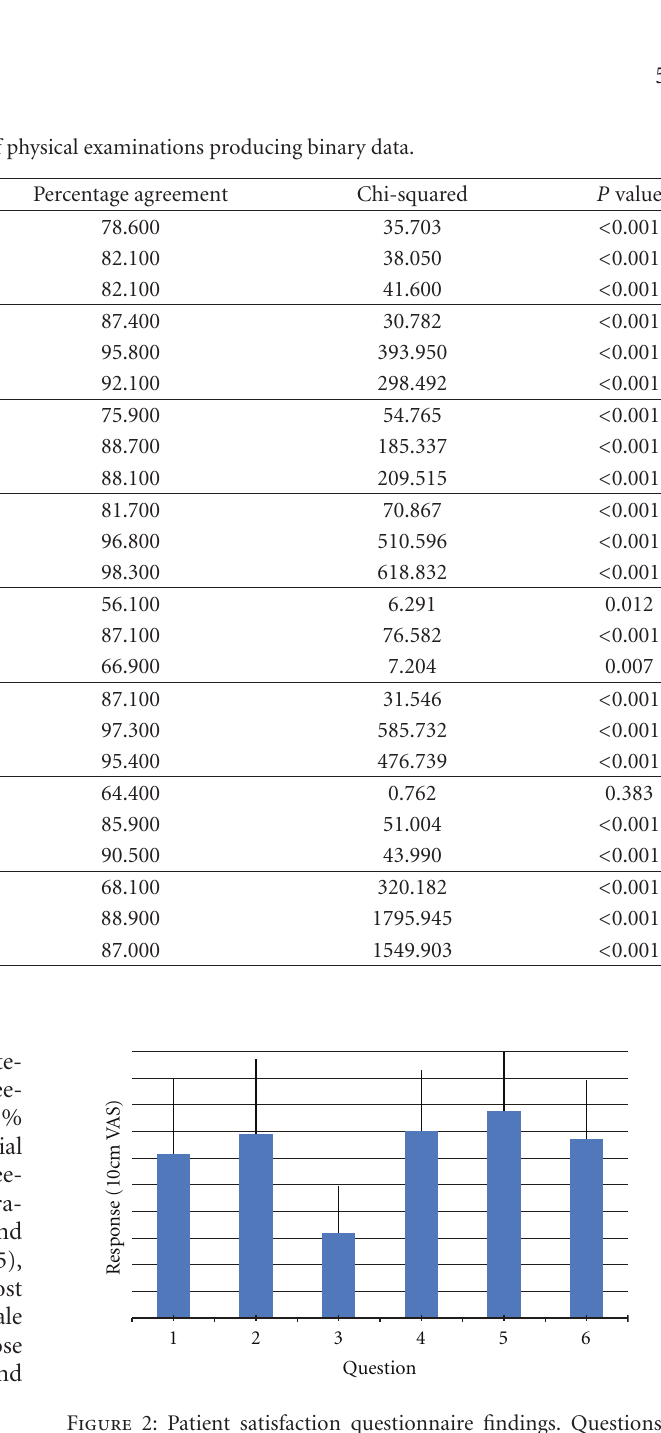
Figure 2: Patient satisfaction questionnaire findings. Questions: (1) How beneficial participants rated the Internet examination, (2) recommend to a friend who was unable to travel, (3) as good as the ‘face-to-face’ examination, (4) visual clarity, (5) audio clarity, (6) overall satisfaction with the Internet